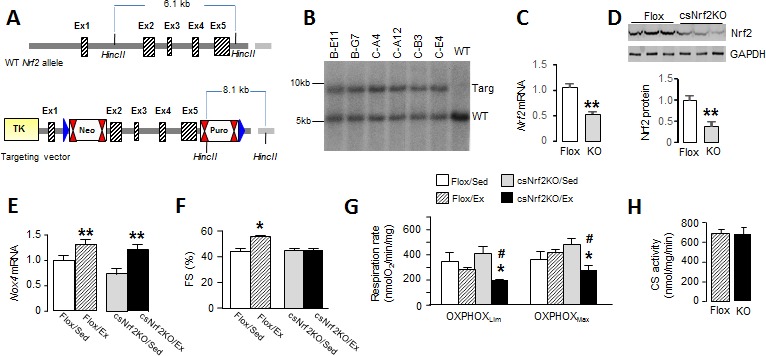
Cardiomyocyte-targeted Nrf2 knockout mice have impaired mitochondrial function and reduced heart performance upon exercise.(A) Targeting strategy for generation of Nrf2fl/fl mice (Flox). The endogenous Nrf2 locus is shown at the top and the targeting vector at the bottom. Exons 2–5 were flanked by LoxP sites which are represented by blue triangles; FRT (Neo) and F3 (Puro) sites are shown by double red triangles. Cre-mediated recombination deletes a 5.5 kb fragment including most of the open-reading frame and the 3’UTR. (B) Southern blot analysis of genomic DNA from selected ES cell clones, performed after excision at HincII sites, showing correct 3’ homologous recombination in all clones. WT indicates wild-type. (C) Nrf2 mRNA levels (n = 6/group) and (D) protein levels (n = 3/group) in the hearts of csNrf2KO and Flox control mice. **p<0.01, 2-tailed t-test. (E) Increase in Nox4 mRNA levels in csNrf2KO and control mouse hearts after acute moderate exercise. **p<0.01 vs respective sedentary controls, 2-tailed t-test (n = 6/group). (F) Fractional shortening (FS) by echocardiography immediately after the exercise capacity test. *p<0.05 vs sedentary (Sed) Flox control mice, 1-way ANOVA followed by Tukey post hoc analysis (n = 6–7/group). (G) Respiration rates in isolated cardiac mitochondria of csNrf2KO and control mice after exercise. Both ADP-limited oxidative phosphorylation (OXPHOSLim) and maximal oxidative capacity (OXPHOSMax) were measured (see Materials and methods for details). *p<0.05 vs csNrf2KO/Sed, # p<0.05 Flox/Ex, 1-way ANOVA followed by Tukey post hoc analysis (n = 4–6/group). (H) Citrate synthase (CS) activity in the heart. n = 4–6/group.